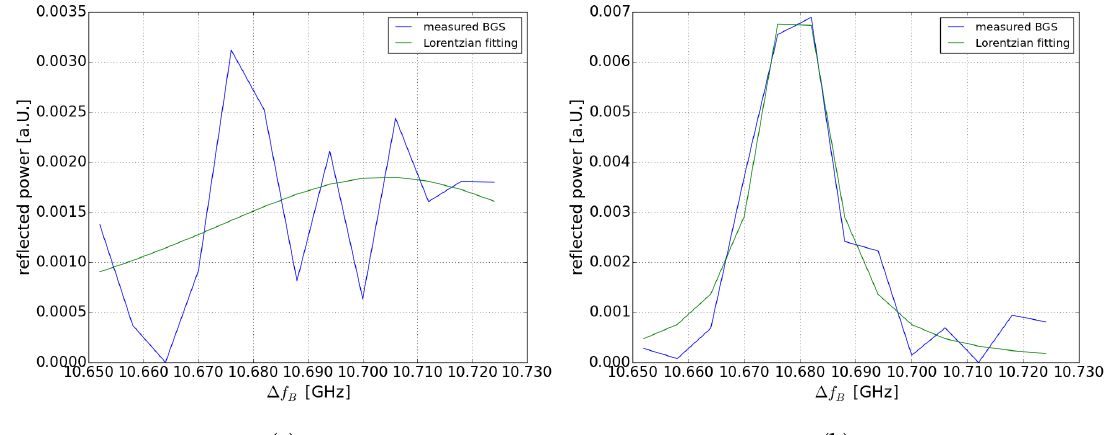
Figure 4. reflected power of the 200-km fiber loop by using a digital high-pass filter ( a ) BGS at 99.478 km within the heated section ( b ) BGS at 99.521 km at room temperature.